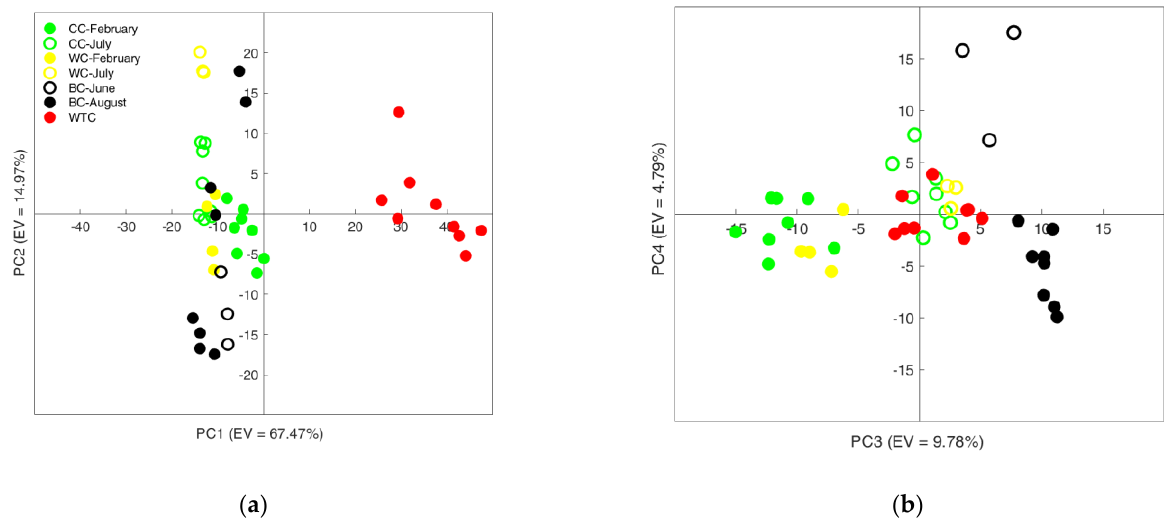
Figure 1. Projection of the celery samples: ( a ) on the PC1-PC2 plane; ( b ) on the PC3-PC4 planes. PCA analysis was carried out on the percentage areas of petiole volatiles after data centering.